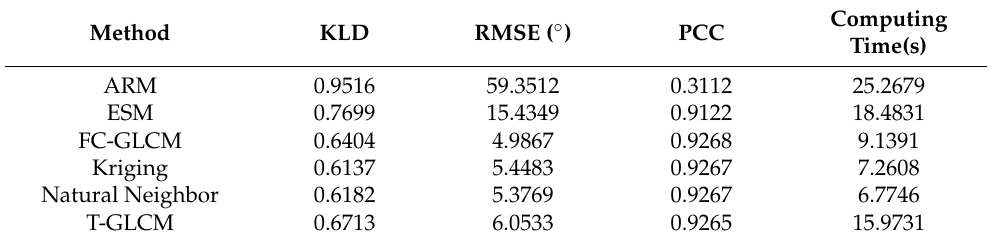
Table 5. Comparison of the proposed FC-GLCM method with classic wind measurement